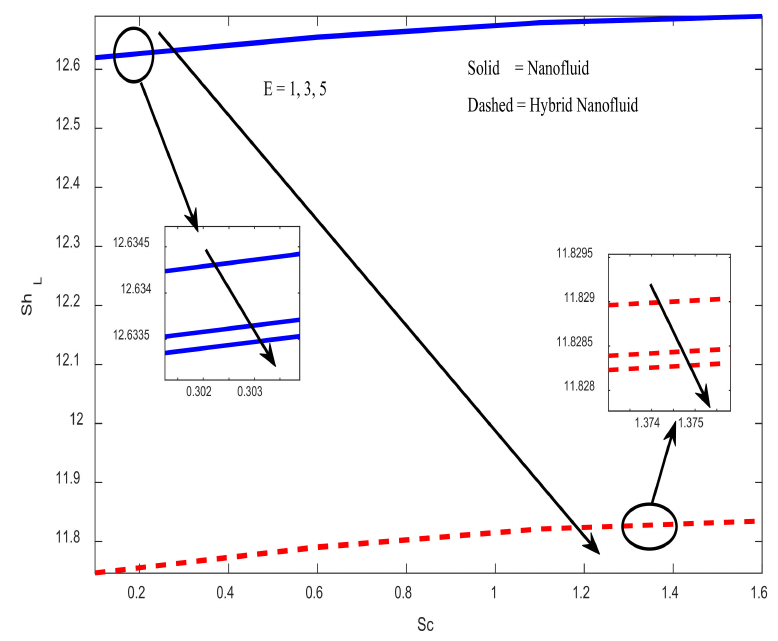
Figure 16. Influence of E on Sherwood number near the lower wall.